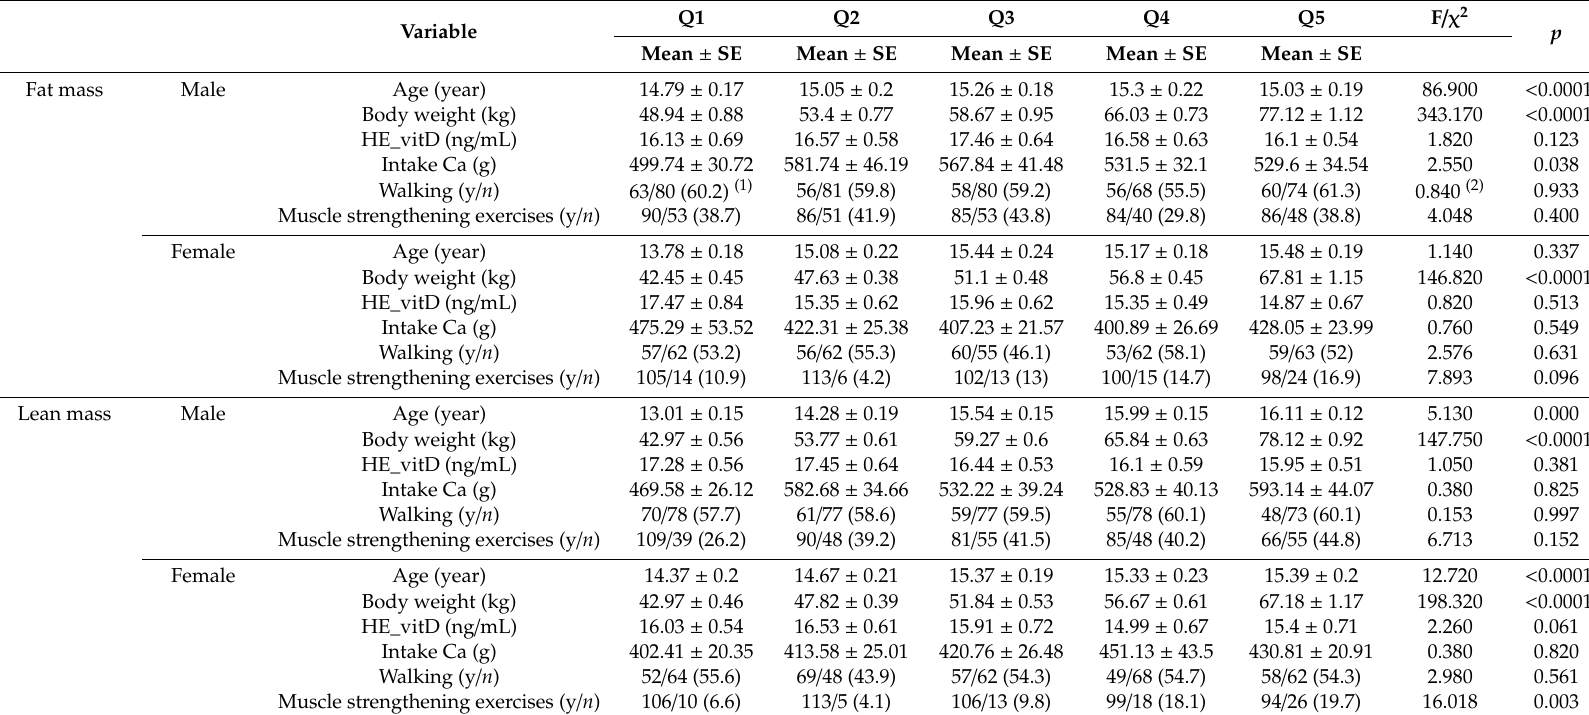
Table 1. Basic characteristics of fat mass levels and lean mass